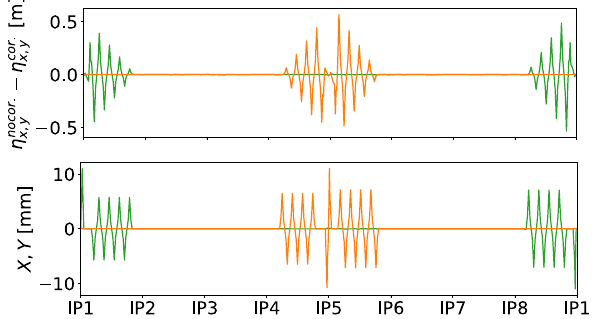
FIG. 18. Orbit bumps (bottom) and the resulting compensation of spurious dispersion (top) in the horizontal (green) and vertical (orange) plane for the 18 × 90 lattice without dispersion sup- pressor collimators. The compensation of spurious dispersion is displayed as the absolute difference between an optics without crossing angles, and an optics with crossing angles and spurious dispersion correction using orbit bumps.